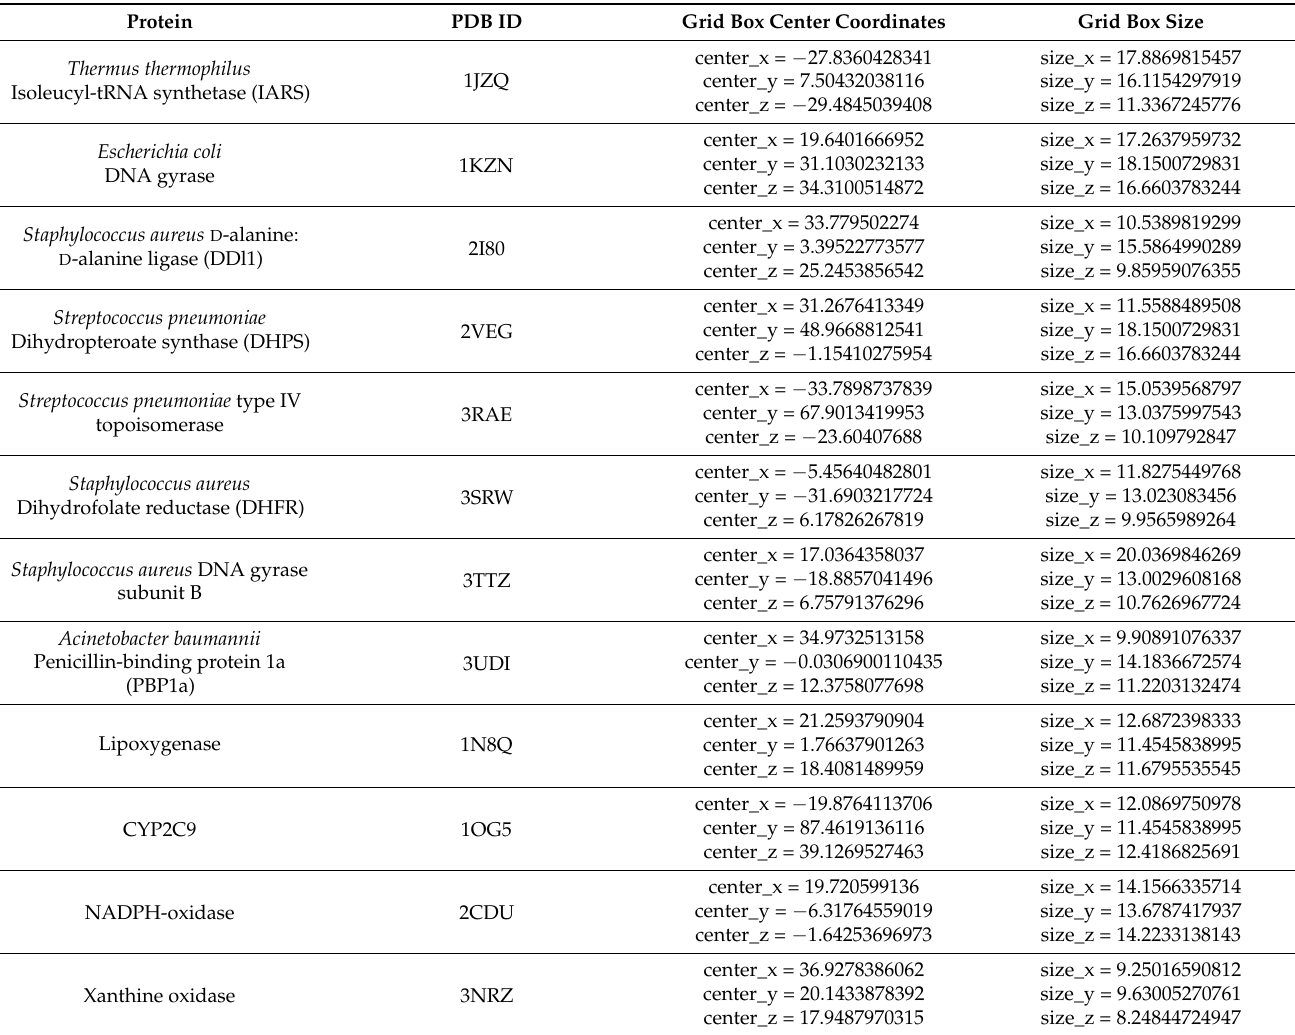
Table 1. Docking parameters used for the in silico evaluation of the 39 TPEO